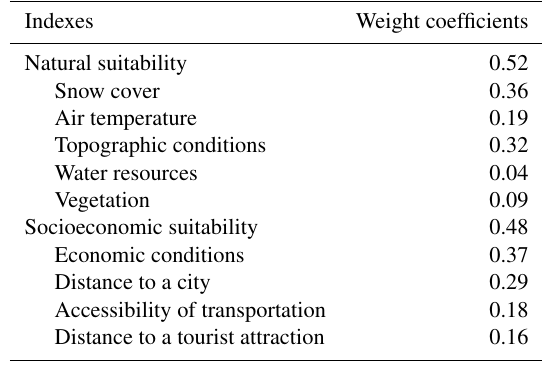
Table 3. Weight coefficients for the evaluation